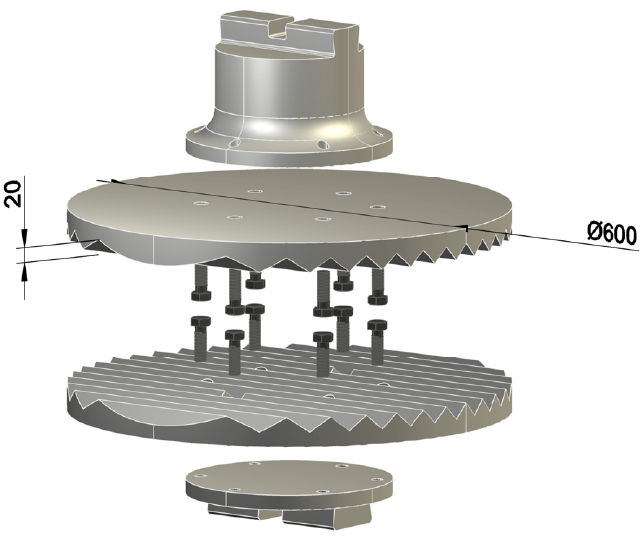
Figure 1. Grooved contact part of the sledgehammer.